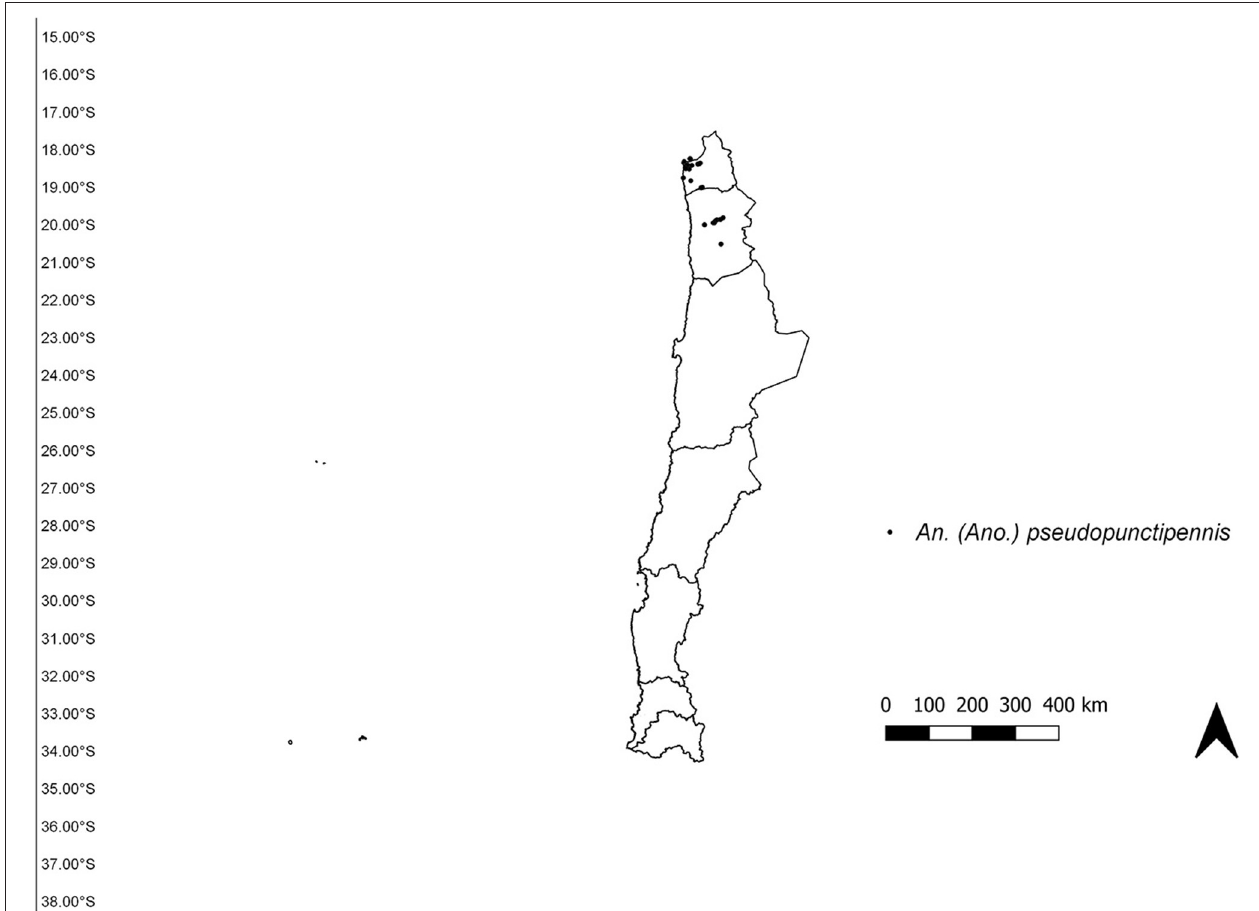
FIGURE 2 | Occurrence records of Anopheles (Ano.) pseudopuntipennis in Chile.